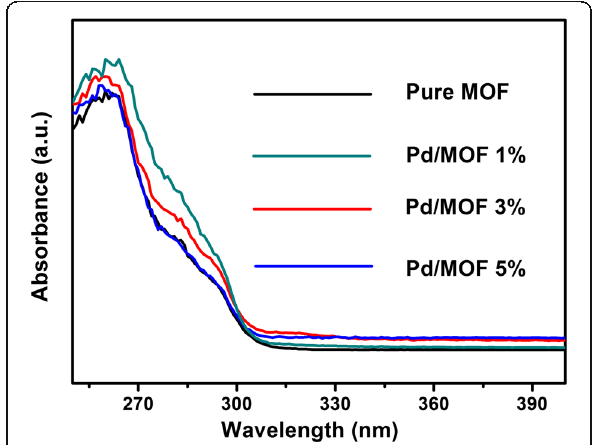
Fig. 7 The UV-vis absorption spectra of pure UiO-66, Pd/MOF 1%, Pd/MOF 3%, and Pd/MOF